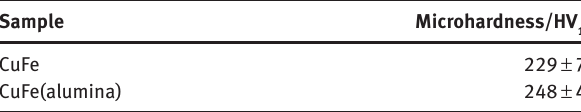
Table 3: Microhardness of CuFe alloy and CuFe(alumina)